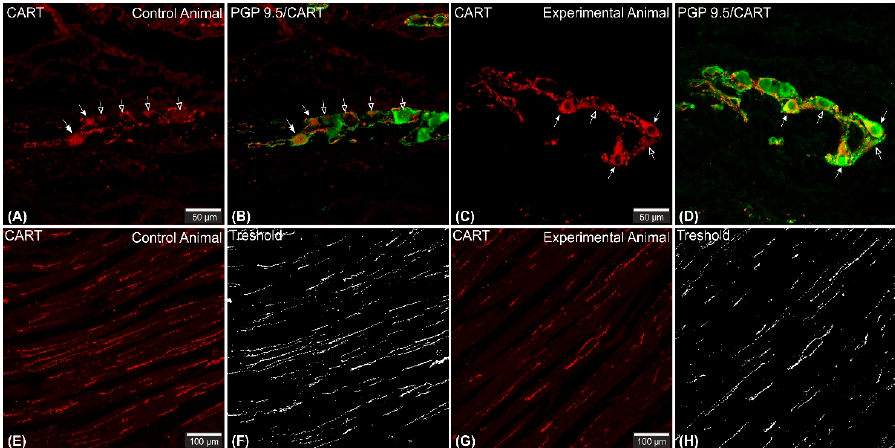
Figure 1. Set of exemplary photomicrographs showing myenteric plexus perikarya ( A – D ; arrows) and nerve fibers ( E , G ) penetrating the circular muscle layer in the control ( A , B , E , F ) and experimental animal ( C , D , G , H ) immunoassayed with antibodies against PGP 9.5 (green channel) and CART (red channel). The number of PGP/CART-IF double immunostained perikarya in experimental animals ( C , D ) was lower than in control pigs ( A , B ). Solid arrows point to highly CART-fluorescent perikarya, empty arrows point to weakly fluorescent cell bodies. In experimental animals perikarya were characterized by stronger immunofluorescence ( C ) than in control ones ( A ). ( E , G ) clearly visible CART-IF varicose nerve fibers penetrating circular muscle layer. ( F , H ) Intermodes threshold method (ImageJ software ver. 1.53c, Rasband, W.S., National Institutes of Health, Bethesda, MD, USA) applied on red channel (CART immunostaining) microphotographs enabled precise quantitative analysis of CART-immunofluorescent nerve fibers in the circular muscle layer indicating their reduction in ulcer animals. Scale bars presented in the pictures.